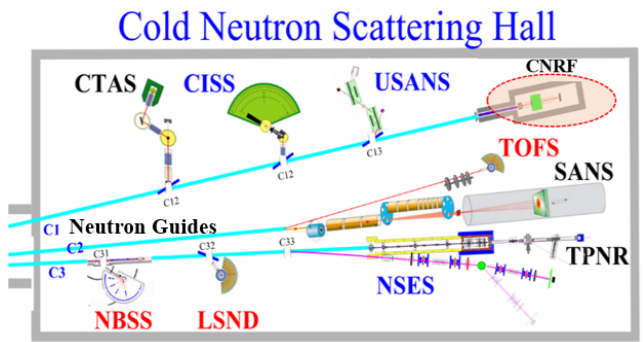
Figure 1. Spectrometer layout of the cold neutron scattering hall.